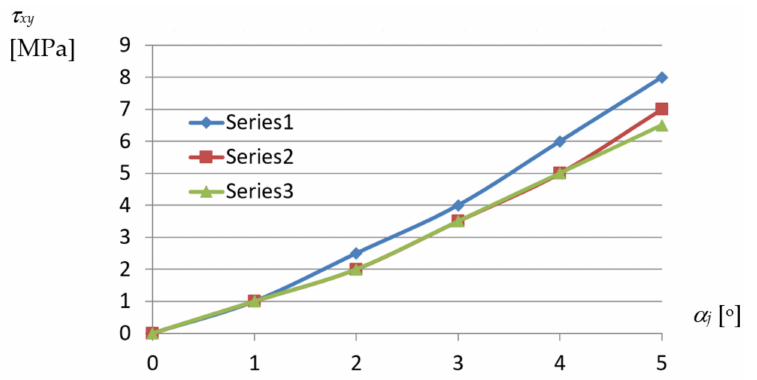
Figure 23. Relations between τ xy shear stresses acting in fold’s walls and α j unit angle of numerically transformed sheets of the following profiles: Series1—TR50 × 0.75 mm × 6.2 m; Series2—TR60 × 0.75 mm × 6.2 m; Series3—TR130 × 0.75 mm × 6.2 m.